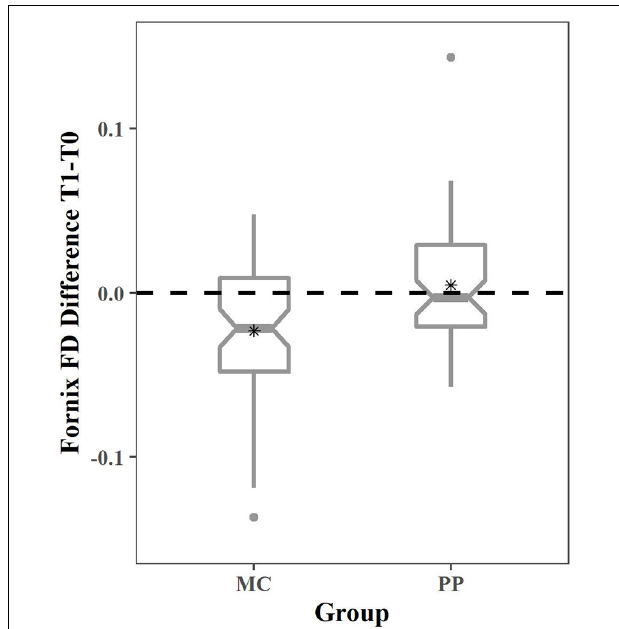
FIGURE 2 | Fiber density change in MC and PP in the fornix. Boxplots depicting the change in FD for the MC and PP group. The dotted line represents no change over time and asterisks (*) depict the group mean. One-sample t -tests revealed no significant change over time in PP and significant FD decrease in MC. T0, baseline measurement; T1, 6 months measurement; MC, music listening/musical culture; PP, piano